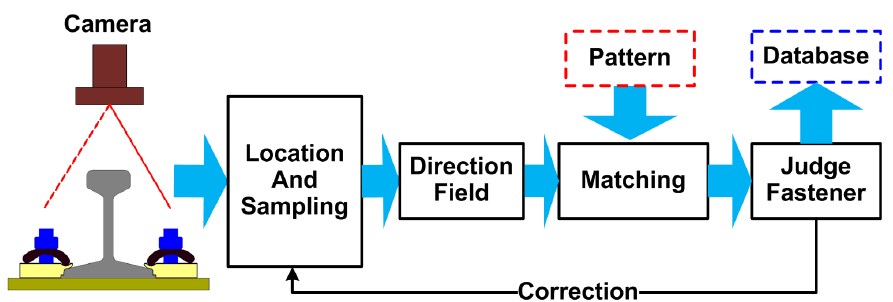
Figure 3. Schematic diagram of the fastener detection